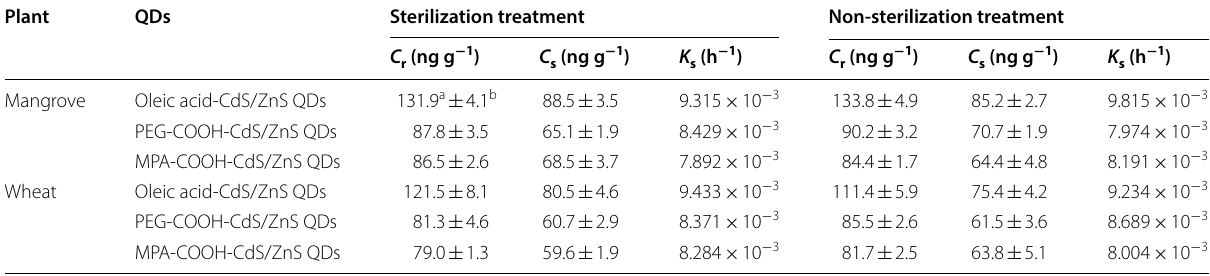
Table 3 The concentrations of CdS/ZnS QDs located on root epidermis after the exposure of 7 days (slow depuration stages)